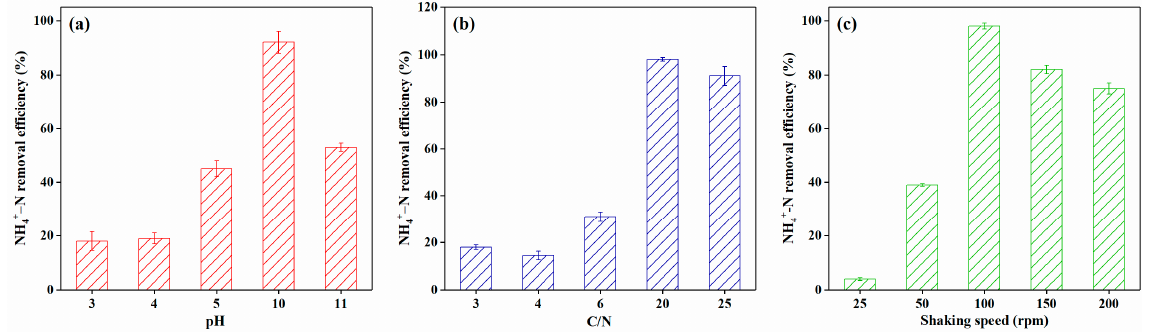
Figure 2. Ammonium removal rate as a function of key factors: ( a ) pH, ( b ) C/N ratio, and ( c ) shak- ing